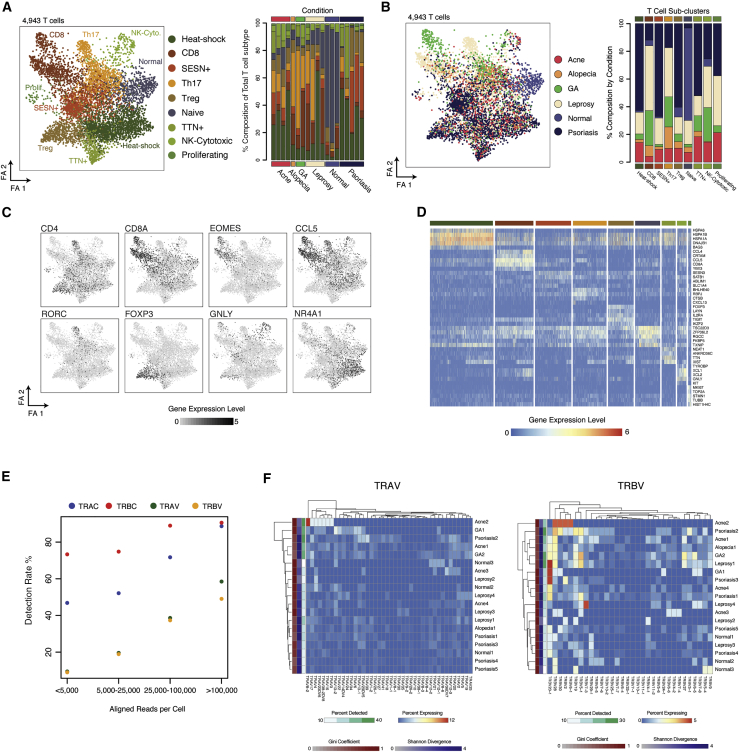
Identification of Inflammatory T cell States by using Seq-Well S3(A) (Left) Force-directed graph of 4,943 T cells colored by phenotypic sub-cluster. Shown on the right is a stacked barplot depicting the distribution of T cell sub-clusters within each biopsy.(B) (Left) Force-directed graph of 4,943 T cells colored by inflammatory skin condition. Shown on the right is a stacked barplot depicting the contribution of each inflammatory skin condition to the T cell sub-clusters.(C) T cell force-directed graphs displaying normalized expression (log(scaled UMI + 1)) of a curated group of sub-cluster-defining gene. Higher expression values are shown in black.(D) Heatmap showing normalized gene expression values (log(scaled UMI + 1)) for a curated list of sub-cluster-defining genes across nine T cell sub-clusters. See also Table S3.(E) Plot showing rates of detection of TCR genes from human skin T cells across a range of sequencing depths.(F) Heatmaps showing the distribution of TRAV (left) and TRBV (right) gene expression among T cells within each sample. Within each sample (rows), the color represents the percent of T cells expressing a given TRAV or TRBV gene (columns). The sidebar shows the gini coefficient (red), the Shannon Divergence (blue), and the percent of T cells (green) within each sample with non-zero expression of either TRAV or TRBV genes.